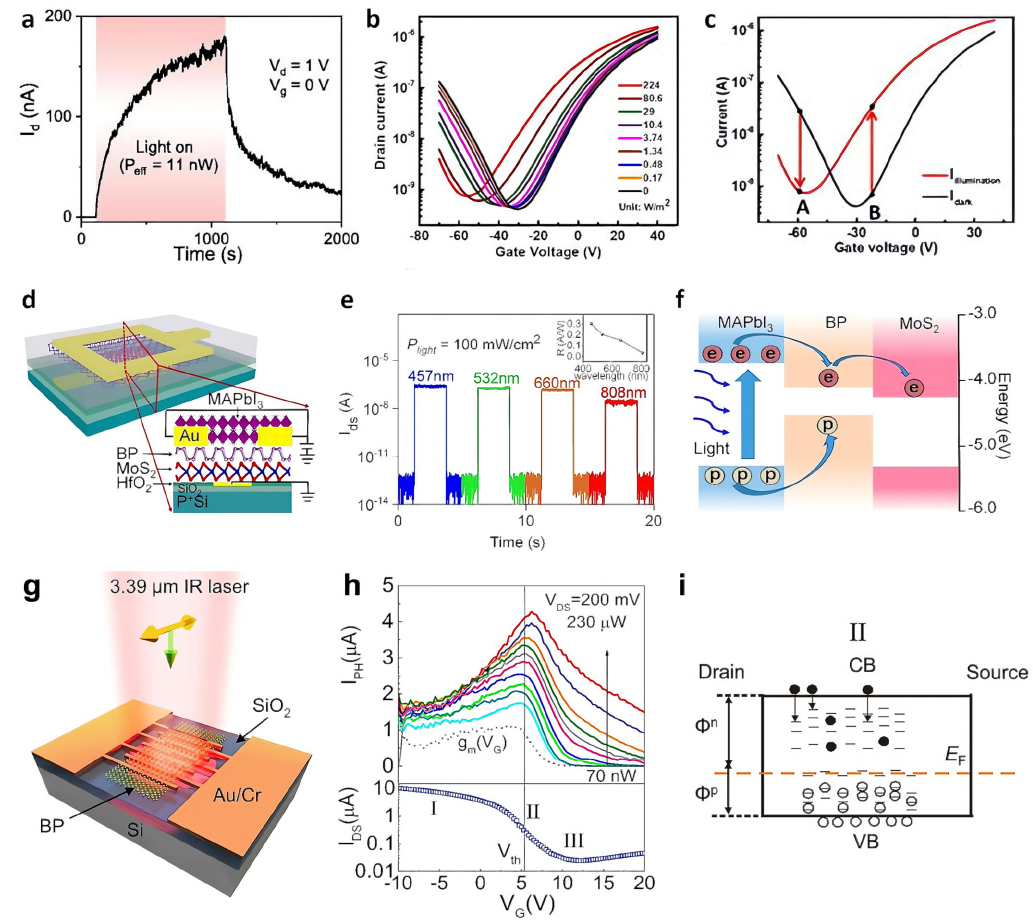
Figure 2. TMD-based photodetector. ( a ) Time evolution of the I D under white LED light illumination (11 nW) when surface treated with O 3 to form a WO x (x < 3) layer on WSe 2 . ( b ) Transfer curve of the PtSe 2 photodetector according to the light intensity with a 405 nm laser irradiation. ( c ) Transfer curve of the PtSe 2 photodetector with (red curve) and without (dark curve) light irradiation. ( d ) Schematic diagram of the perovskite/BP/MoS 2 photodiode. ( e ) Time evolution of the I D (V D = 0) with different wavelengths of 457, 532, 660, and 808 nm. The inset shows the corresponding R . ( f ) Sche- matic band diagram and photocarrier transfer of the device under laser illumination. ( g ) Scheme of the BP photodetector. ( h ) Upper panel: gate-dependent I Ph measured according to the various inten- sities of 532 nm light. Lower panel: transfer curve corresponding to the upper panel for reference at V D = 200 mV. ( i ) Schematics of the energy band for the state II (V G ≈ V Th ) of ( h ). The down arrows denote the carrier trapping process. The black dots and open circles represent electrons and holes, respectively. ( a ) Reproduced with permission from [91]. Copyright AIP Publishing, 2018. ( b , c ) Re- produced with permission from [94]. Copyright AIP Publishing, 2021. ( d – f ) Reproduced with per- mission from [88]. Copyright American Chemical Society, 2019. ( g – i ) Reproduced with permission from [103]. Copyright American Chemical Society, 2016.